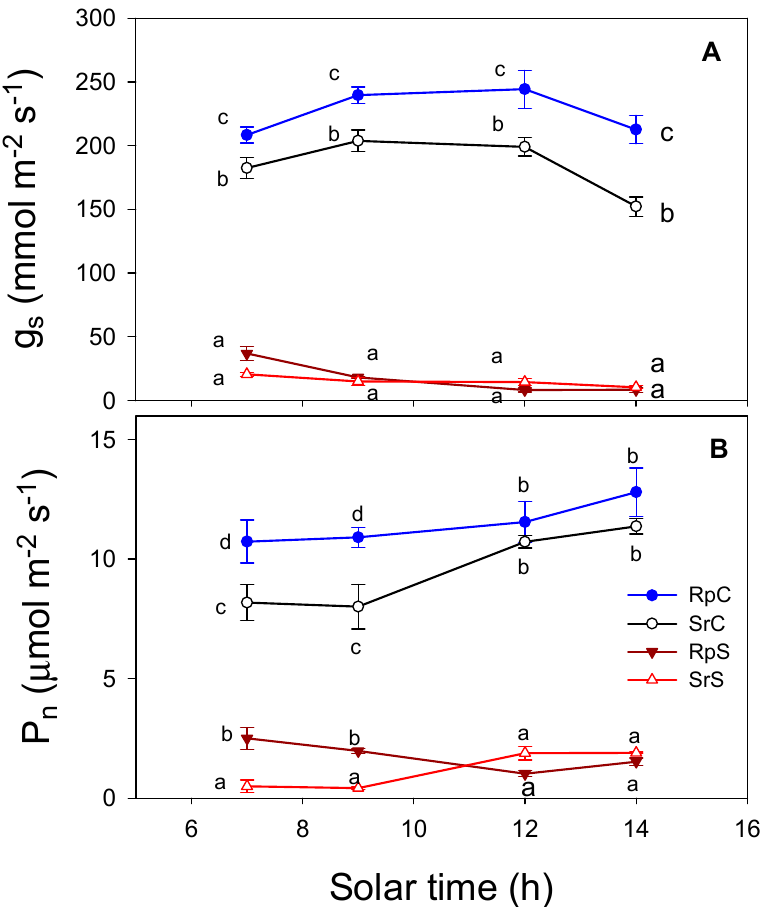
Figure 6. Evolution of hourly g s ( A ) and P n ( B ) throughout a representative day at the end of water stress in P. dulcis plants submitted to di ff erent treatments. Values are means + s.e., n = 6. Symbols represent the di ff erent treatments: RpC (filled circles; plants grafted under full irrigation), SrC (open circles; self-rooted plants under full irrigation), RpS (filled triangles; plants grafted submitted to water stress) and SrS (open triangles; self-rooted plants submitted to water stress). Di ff erent lowercase letters indicate significant di ff erences between treatments according to Duncan 0.05 test.